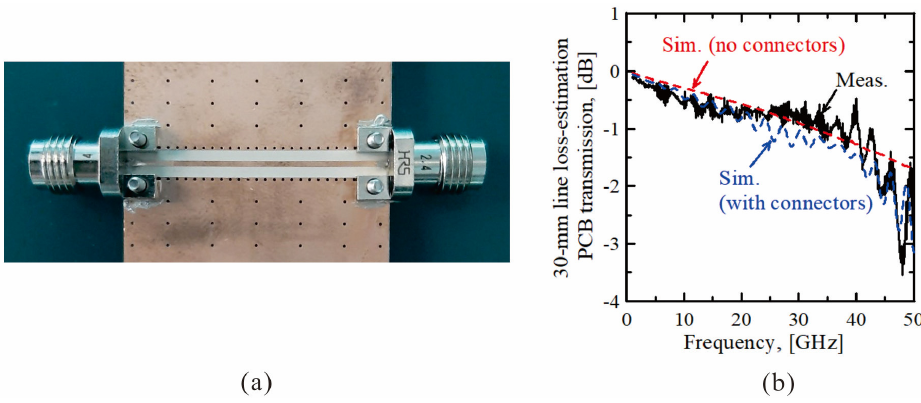
Figure 3. ( a ) Loss-estimation PCB and ( b ) the measured and simulated losses.